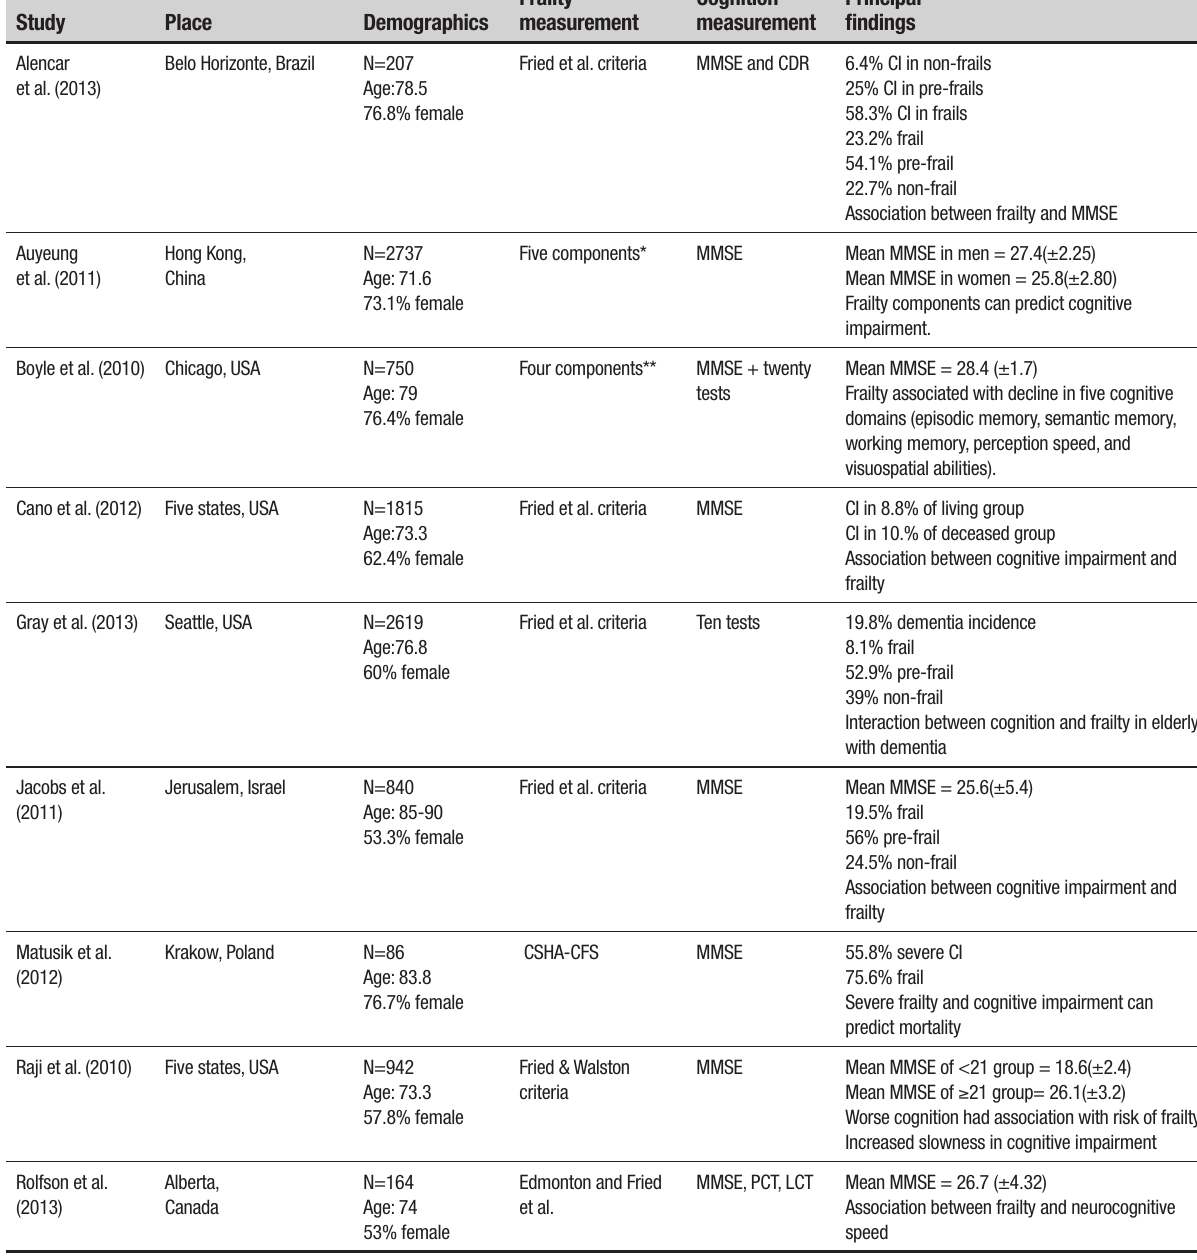
Table 2. Longitudinal studies on the relationship between cognition and frailty in